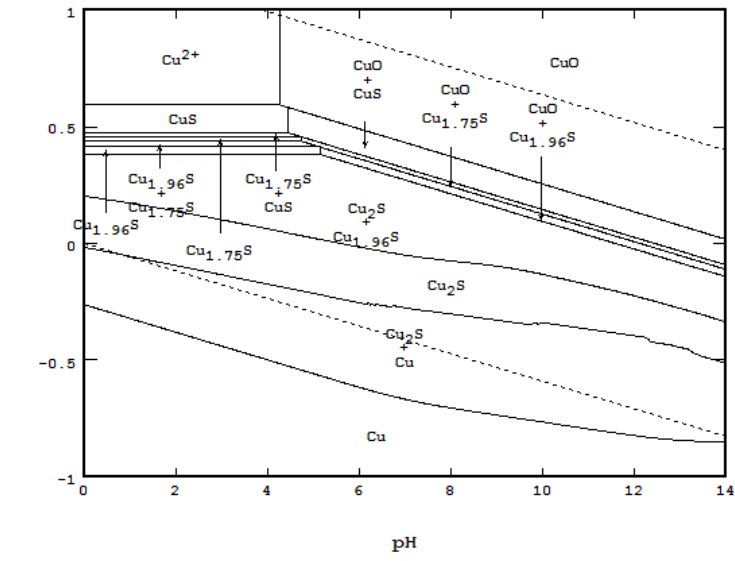
Figure 14. Eh-pH diagram for the Cu–S–water system constructed by the mass-balance point-by-point method. This diagram matches Figure 5 of Wood et al. [8].